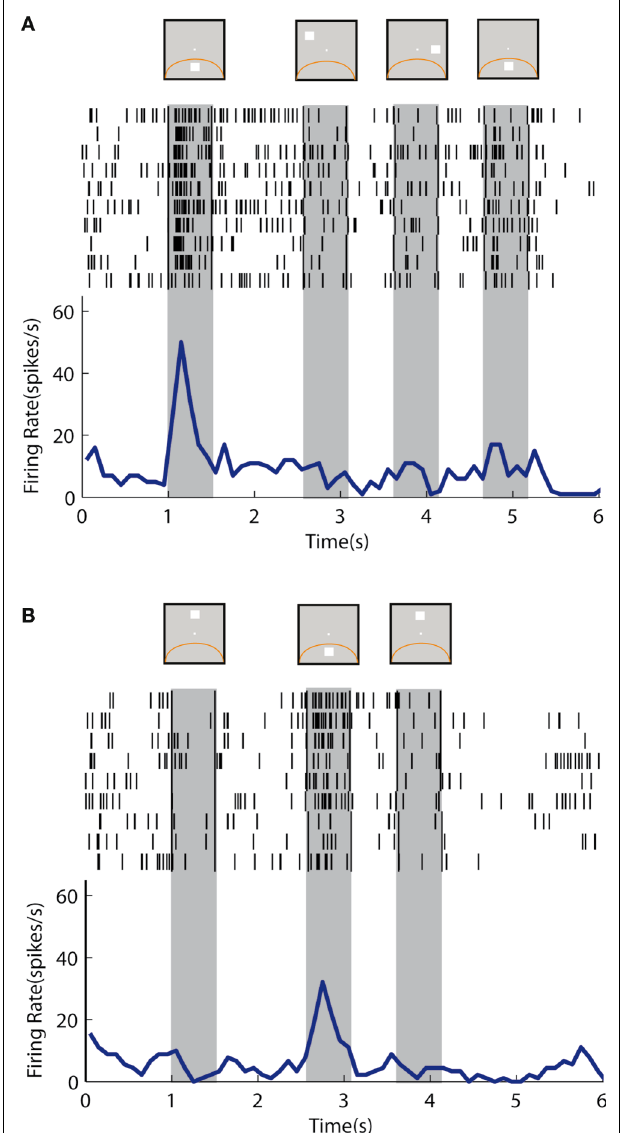
FIGURE 10 | Rasters and histograms of one neuron with sustained activity recorded from area 46 of the dorsolateral prefrontal cortex, tested with the delayed match-to-sample task. (A) Responses to the cue presentation in the receptive fi eld followed by nonmatch presentations out of the receptive fi eld. (B) Responses to the cue presentation out of the receptive fi eld followed by a nonmatch presentation in the receptive fi